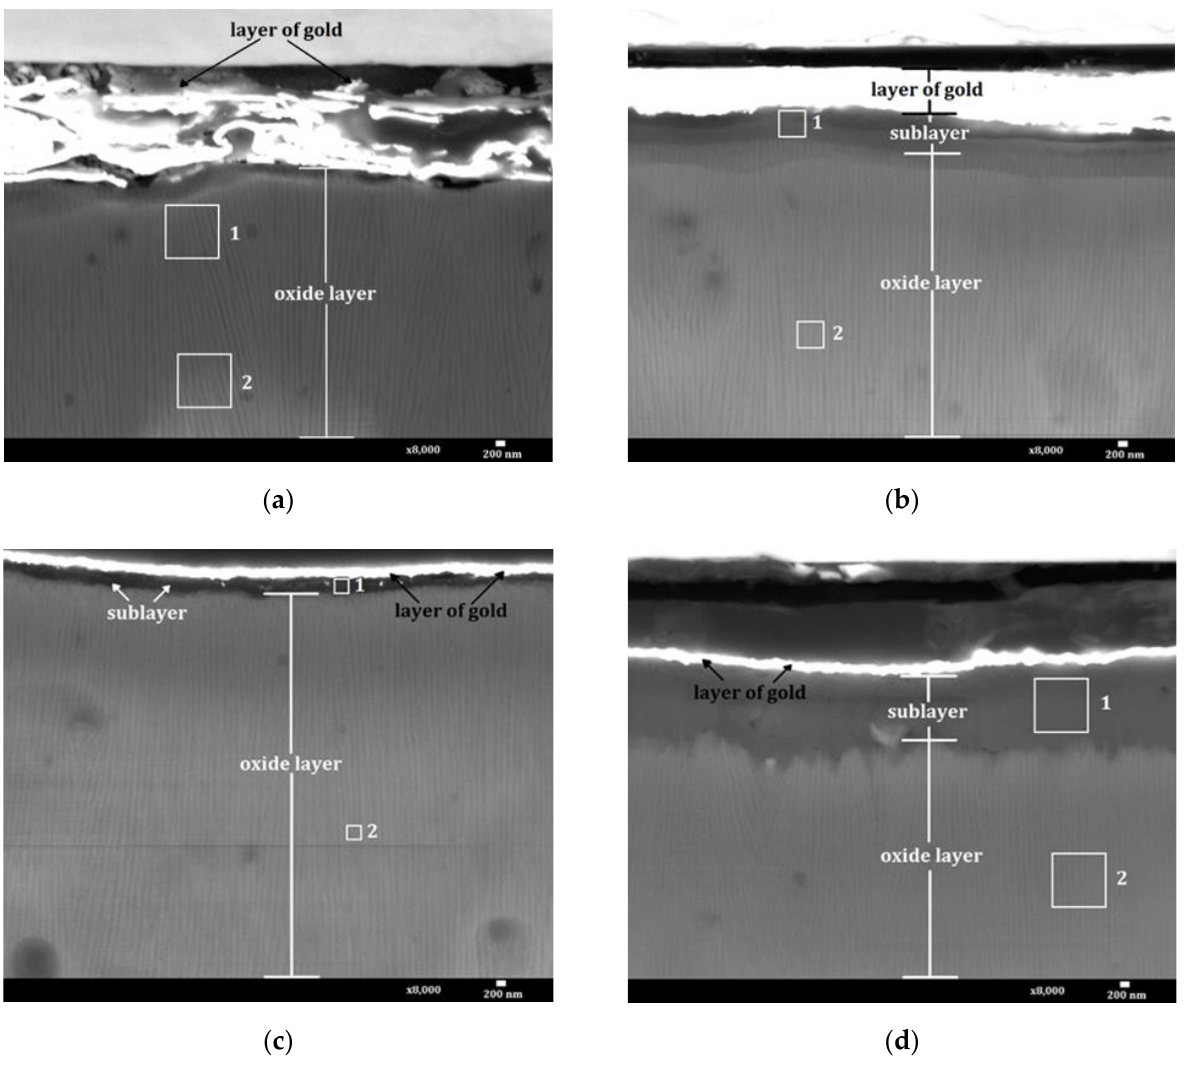
Figure 2. Nanostructure of layers: ( a ) Sample 1, ( b ) Sample 2, ( c ) Sample 3, ( d ) Sample 4. Table 2. Thickness of sub-layer obtained by thermo-chemical treatment.